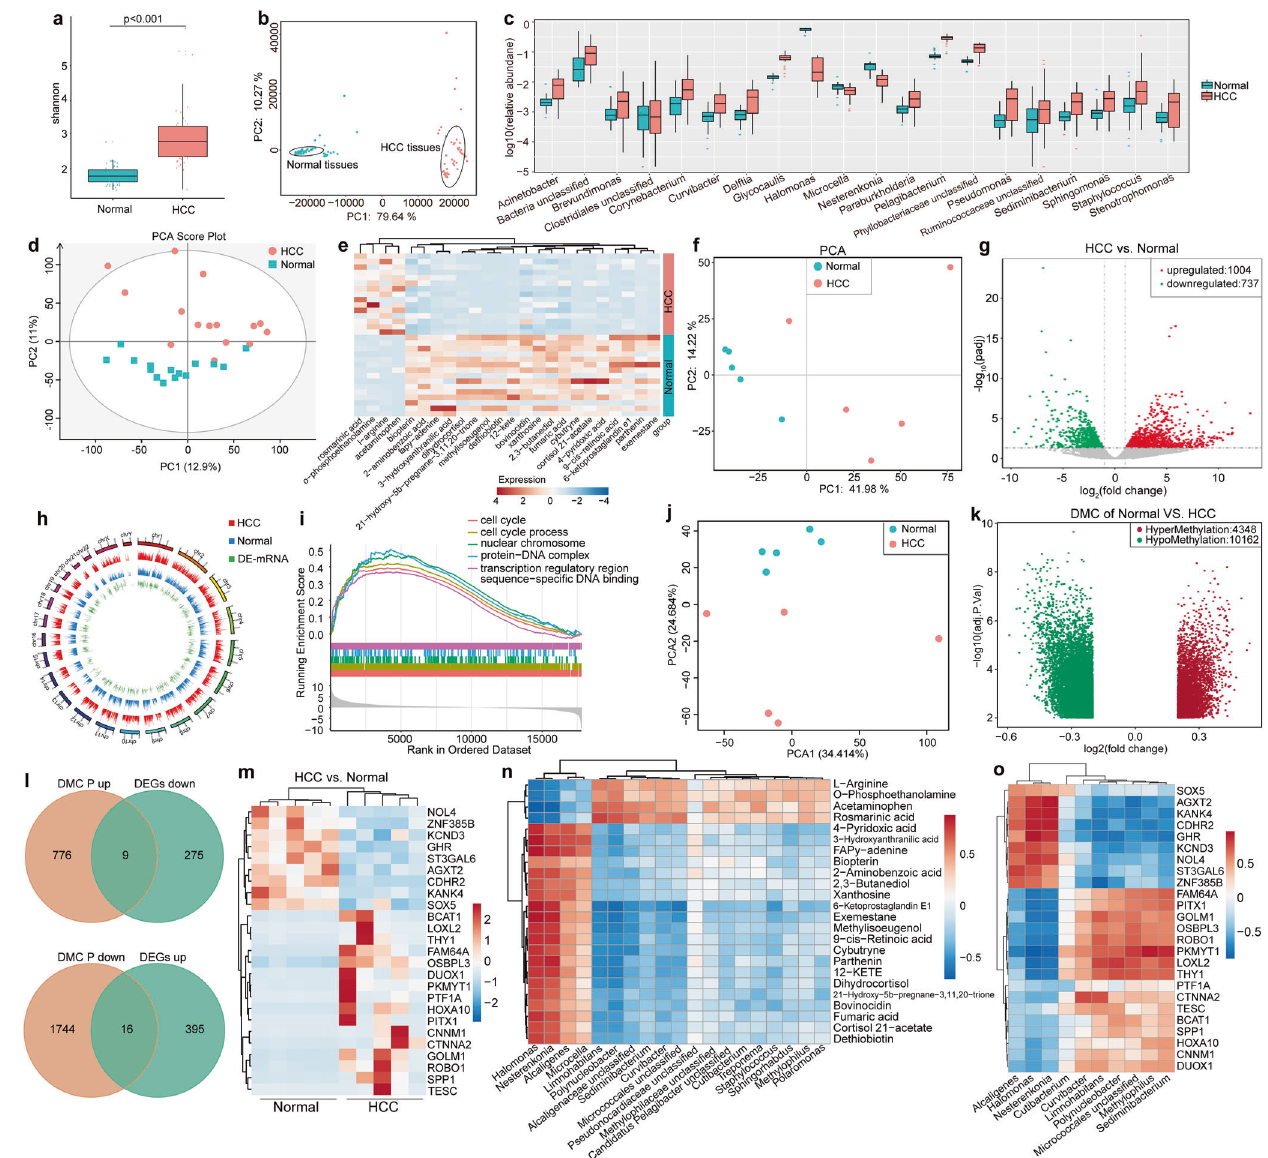
Fig. 1 Tumor microbiomes were closely associated with changes in host metabolism and epigenetic and gene expression pro fi les. a Shannon index of the microbiota of samples from tumor tissues and normal control liver tissues. The vertical axis represents the α diversity of the micro fl ora. Different colors represent different groups of samples. b PCA scatter plots of microbiota between tissue samples. c The top 20 microbial taxa with signi fi cant differences in relative abundance between HCC tissues and healthy tissues. d PCA scatter plots of metabolomes between tissue samples (* p < 0.05; ** p < 0.01). e Differential metabolites from cancer tissues and adjacent tissues were identi fi ed based on heatmap analysis of Euclidean hierarchical clustering. The horizontal axis represents the different metabolites, the vertical axis represents the samples of different groups, and the red and blue colors represent an increase and a decrease in metabolism, respectively. f PCA scatter plots of transcriptomes between tissue samples. g Volcano plot of the DEGs in the HCC and paired samples. The abscissa represents the log2FoldChange of gene expression between different groups. The ordinate represents the signi fi cance level of the expression difference. h Differential gene genome circle diagram. The outermost circle is the chromosome band, the innermost circle is the histogram of the log2FoldChange value of the DEGs, and the middle two circles are the log2(FPKM + 1) distribution diagrams of the two groups of genes. i GSEA of DEGs was s i gni fi cantly correlated with cell cycle, cell cycle process, nuclear chromosome, protein-DNA complex, transcription regulatory region, and sequence-speci fi c DNA binding pathway. j PCA scatter plots of genes DNA methylation between tissue samples. k Volcano plot of the different methylation genes in the HCC and paired samples. The abscissa represents the log2FoldChange of gene expression between different groups. The ordinate represents the signi fi cance level of the expression difference. Red dots represent hypermethylation. Green dots represent hypomethylation. Gray dots represent that the difference in methylation was not statistically signi fi cant. l Venn diagram of gene data showing opposite trends of DNA methylation in promoter regions and corresponding gene expression levels. m Heatmap of DNA methylation-related differential genes. n Correlation between different bacterial classes and the 24 most abundant metabolites in HCC tissues and healthy liver tissues. o Spearman correlation analysis between the microbiome and DNA methylation-related differential genes. Abbreviation: PCA principal component analysis. HCC hepatocellular carcinoma; DEGs differentially expressed genes; FPKM Fragments Per Kilobase per Million